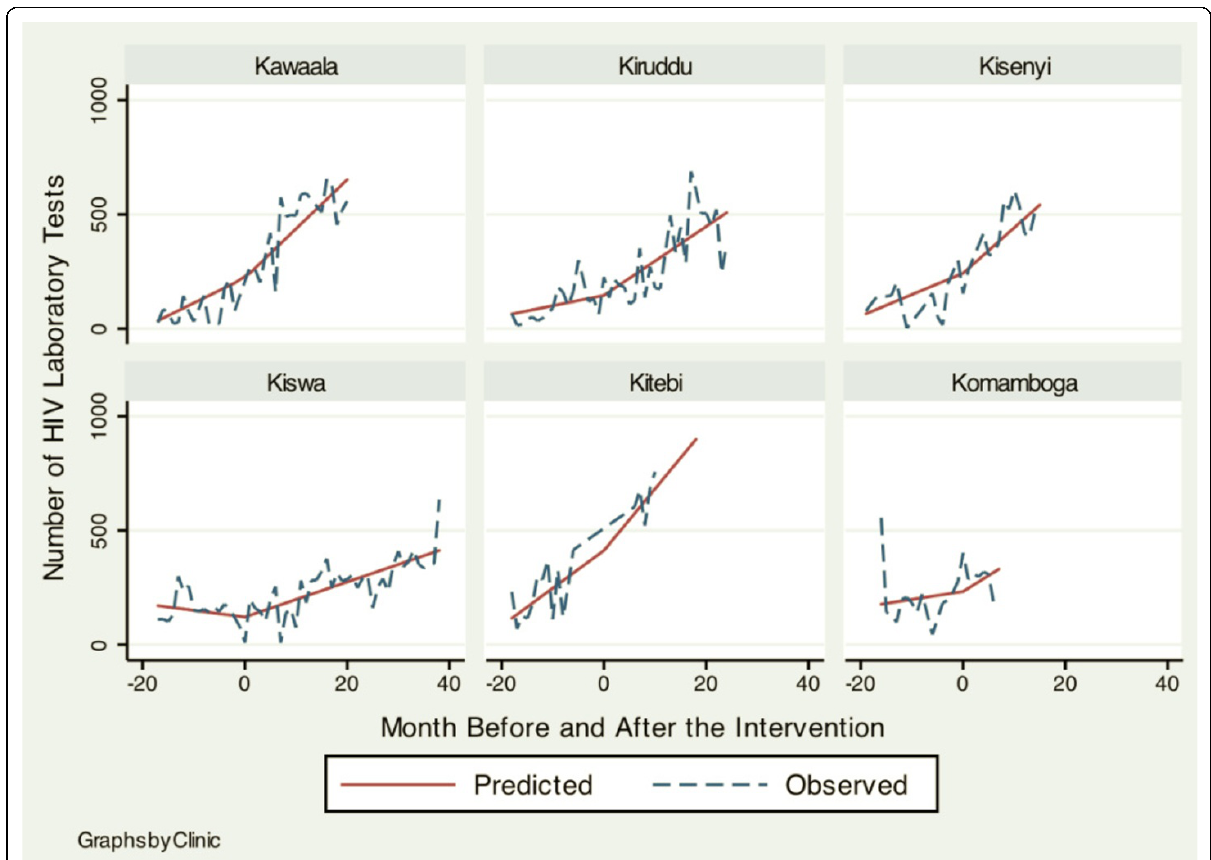
Figure 1 Fitted trends for key health services . Graphs by